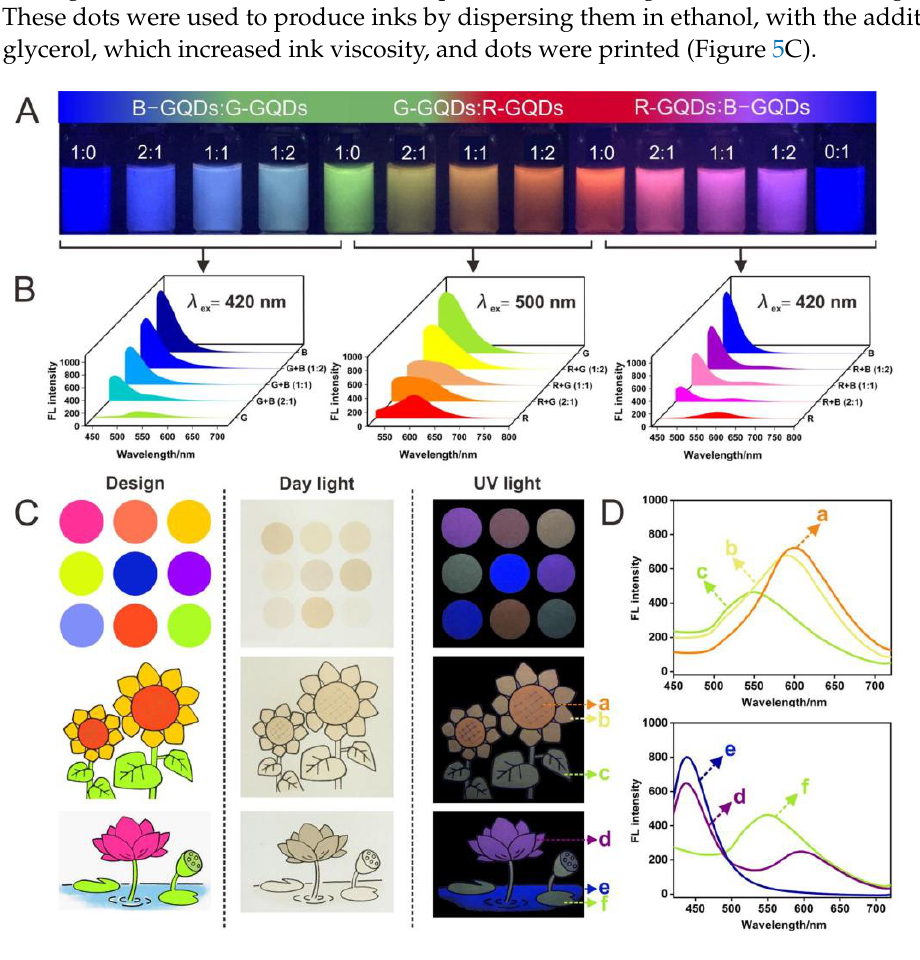
Figure 5. ( A ) Color range of GQDs mixtures, ( B ) emission PL spectra of selected mixtures, ( C ) printed GQDs images under daily and UV lights and ( D ) emission PL spectra of region that was indicated by arrows. Reprinted from Journal of Colloid and Interface Science , 579, Jingwen Zhao, Yanyan Zheng, Youyou Pang, Jie Chen, Zheye Zhang, Fengna Xi, and Peng Chen, Graphene quantum dots as full-color and stimulus-responsive fluorescence ink for information encryption , 307, copyright (2022), with permission from Elsevier [78].